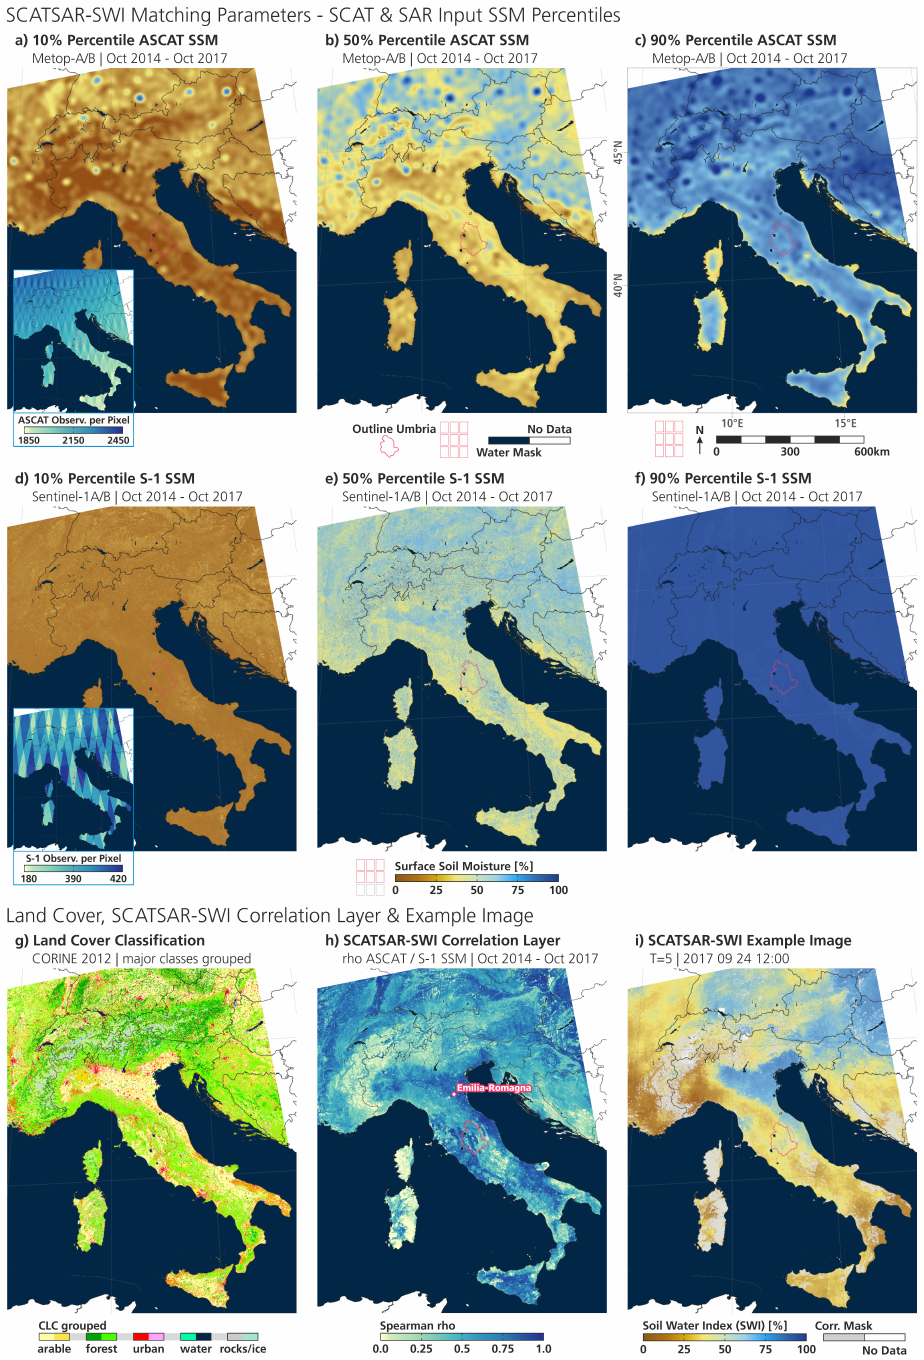
Figure 4. Collection of SCATSAR data fusion parameters and example SWI image over Italy, with land cover data for comparison. The Umbria region (acting as evaluation area) is outlined in red. No-data areas are white. ( a – c ) selected SCAT Matching Parameters; displaying here the 10%, 50%, and 90% percentiles of the ASCAT SSM distribution. The mini-map in ( a ) displays the number of ASCAT SSM observations in the period October 2014–October 2017; ( d – f ) as above, but for SAR from S-1 SSM; ( g ) land cover from CORINE 2012, grouped to major types; ( h ) SCATSAR-SWI Correlation Layer, holding the Spearman Rho between ASCAT and S-1 SSM; ( i ) example SCATSAR-SWI image at 24 September 2017, at T -value = 5 and with Correlation Mask